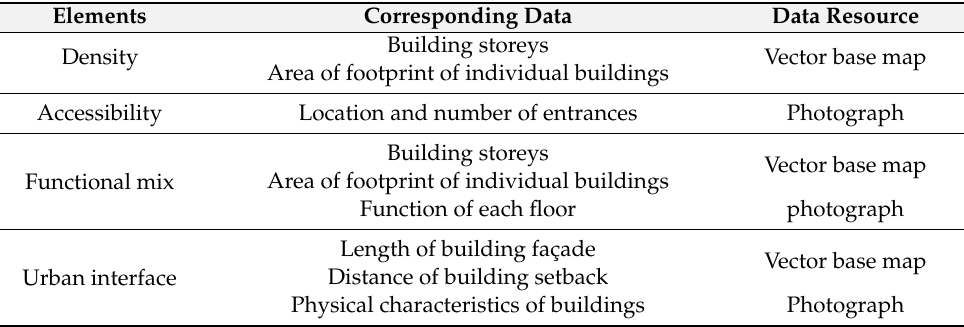
Table 1. Data resources for the morphological